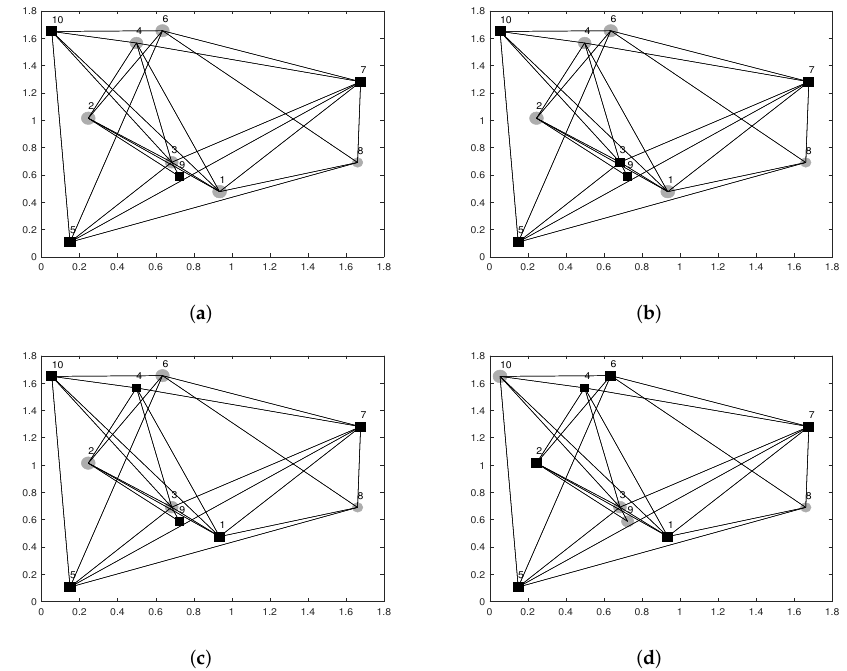
Figure 5. Spatial location of healthcare centers with a maximum coverage level (1,044,779) for different values of k in instance 1 with: ( a ) k = 3; ( b ) k = 4; ( c ) k = 5; and ( d ) k = 6; where 1 to 10 • are the geographical zones, with and (cid:4) sketching a zone discrete center and a healthcare center location, respectively.